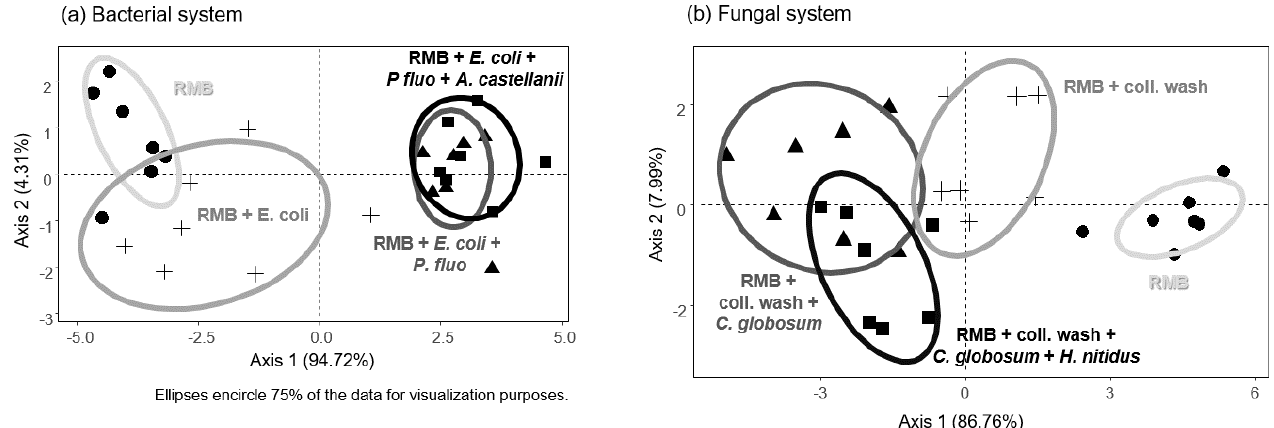
Figure 2. Effect of bacterial and fungal consumer–prey inoculations on bacterial community composition. Discriminant function analysis of the bacterial PLFA markers in the (a) bacterial and (b) fungal systems. Overall differences in bacterial PLFA composition (eight markers) within the bacterial and fungal systems were analysed first by NMDS followed by MANOVA. Pairwise differences between means were further investigated using Mahalanobis distances. For details of the results of the statistical tests see Table 2. RMB: remaining microbial